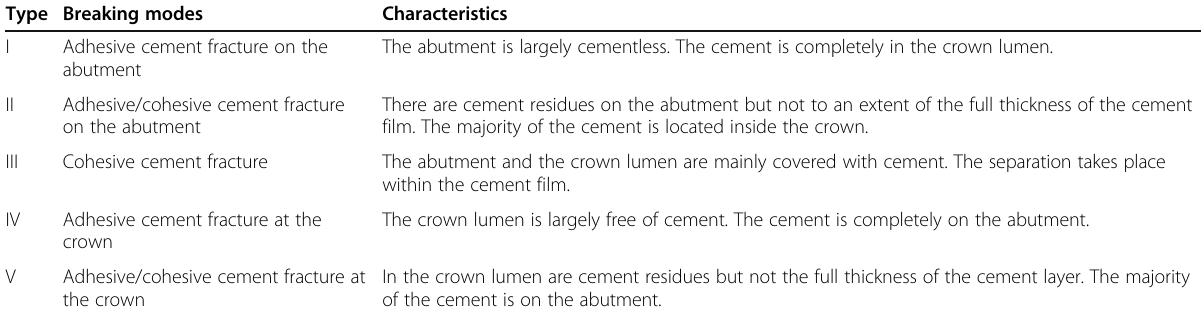
Table 1 Classification of the breaking modes and their characteristics Type Breaking